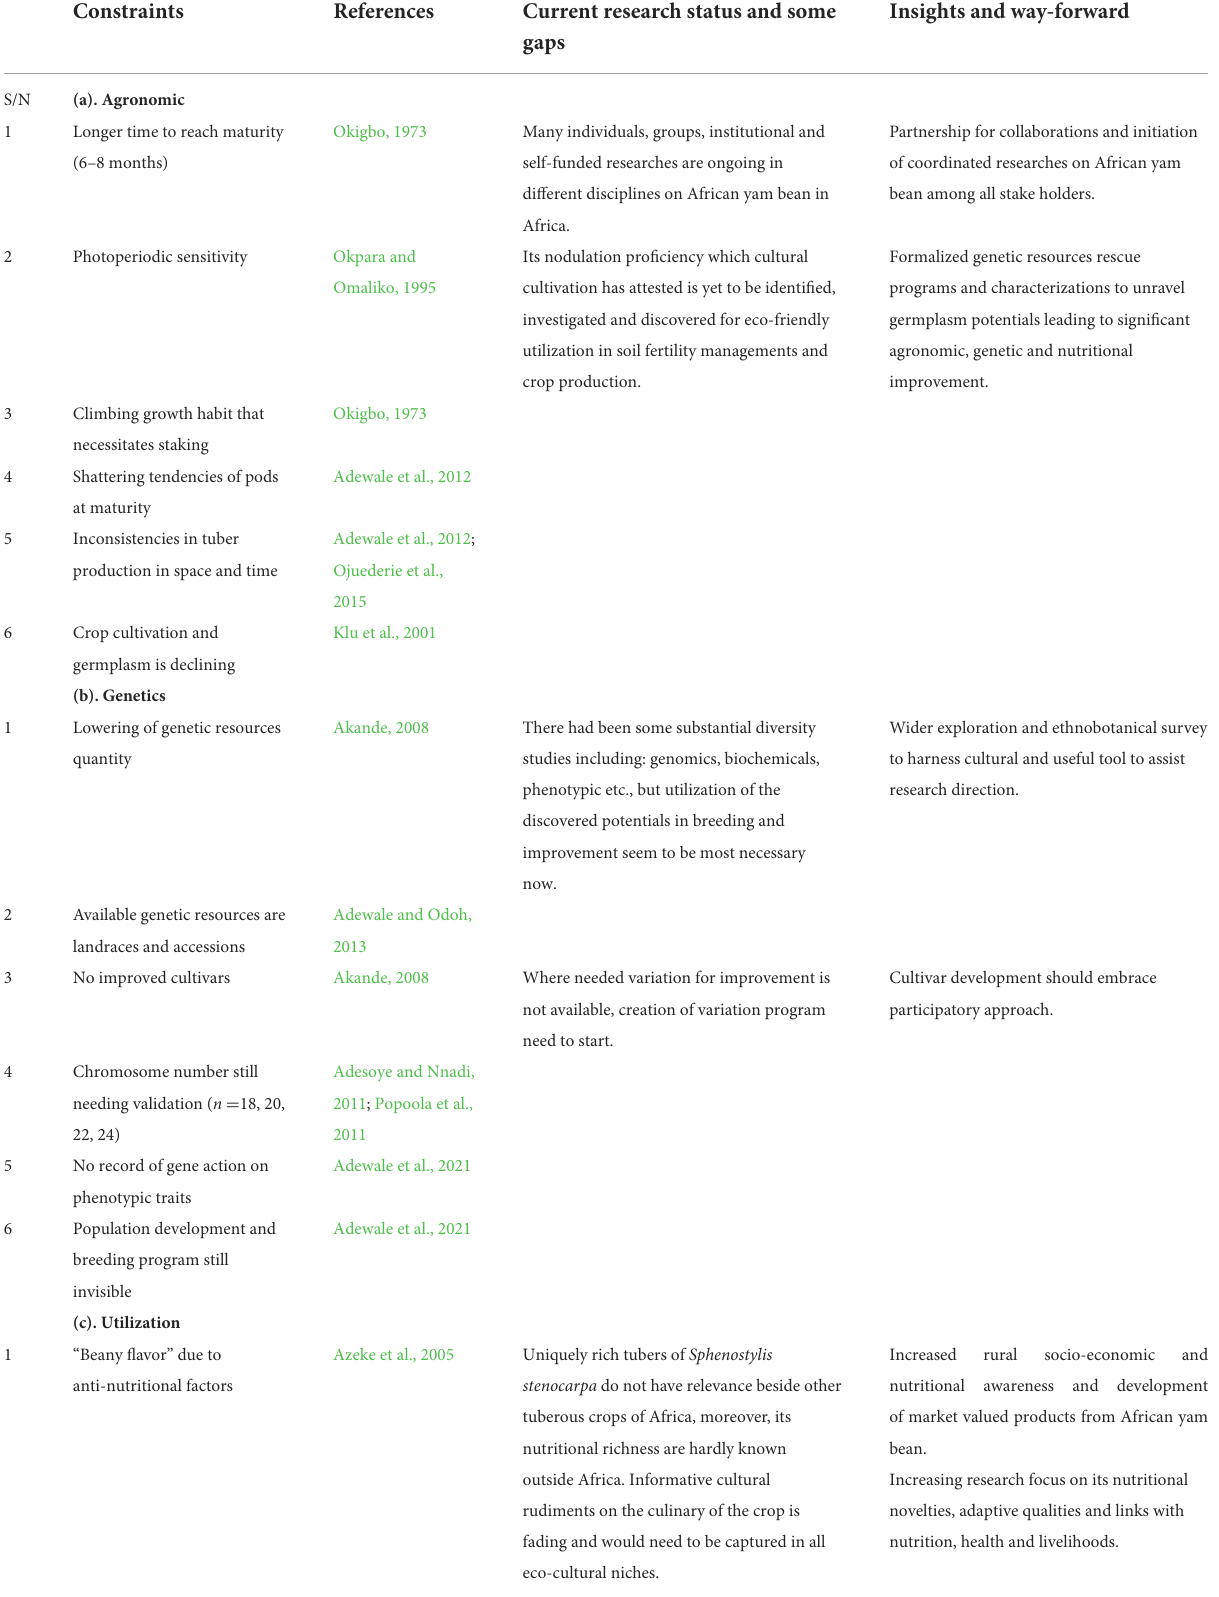
TABLE 2 Constraints, gaps, insights and way-forward in African yam bean research.